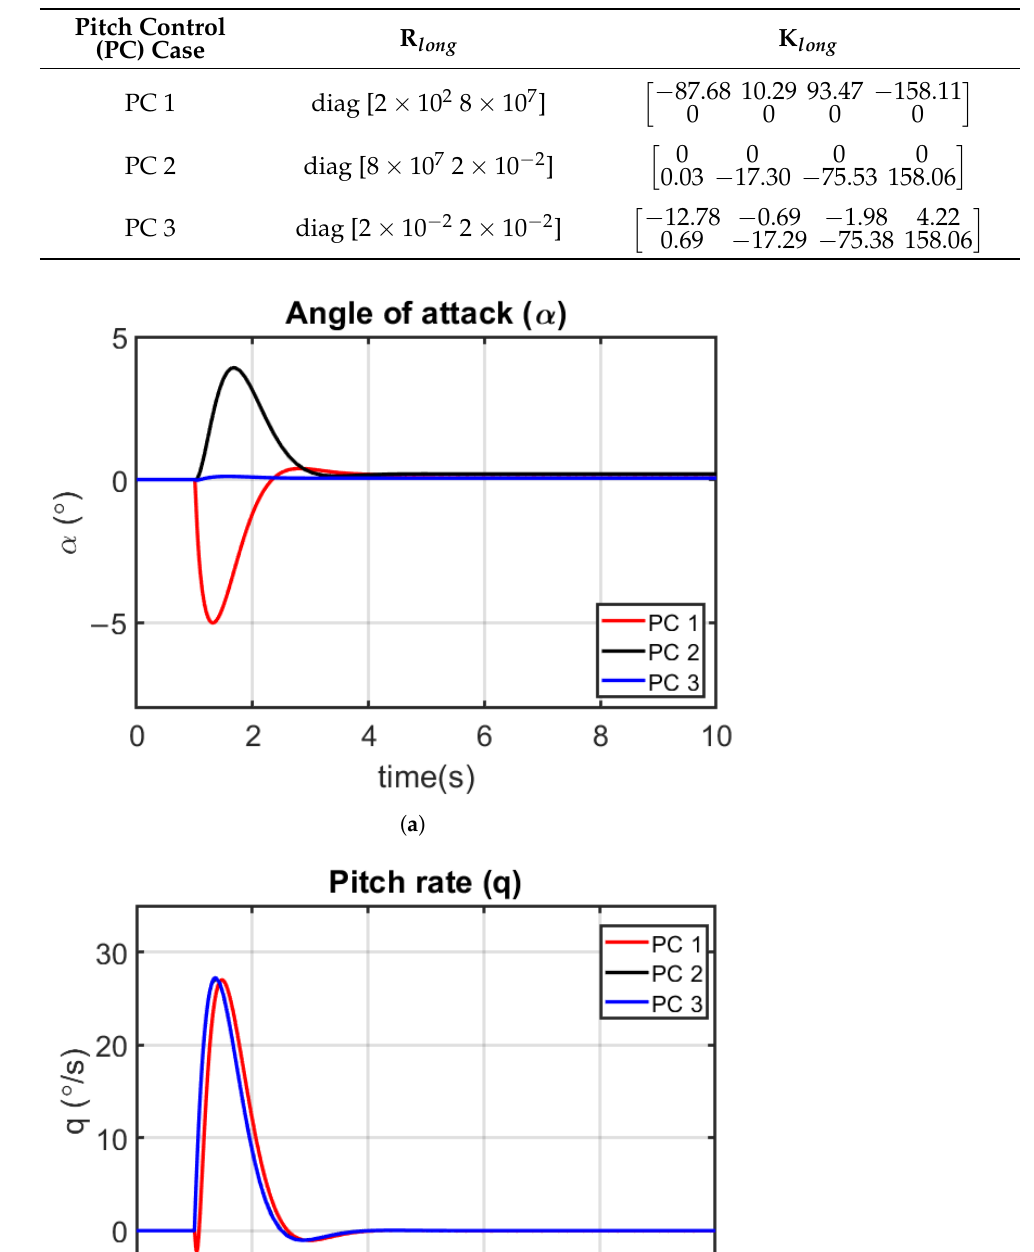
Table 5. Simulation parameters for pitch control (PC) cases.